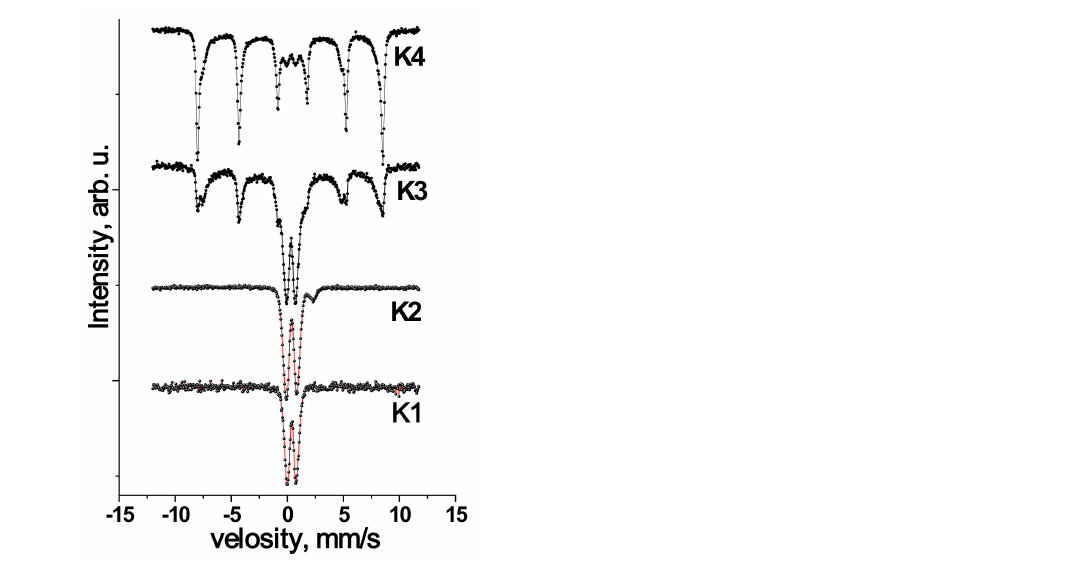
Figure 2. Mossbauer spectra of synthesized materials and after annealing at different temperatures. Table 1. The parameters of the spectra of samples obtained at different annealing